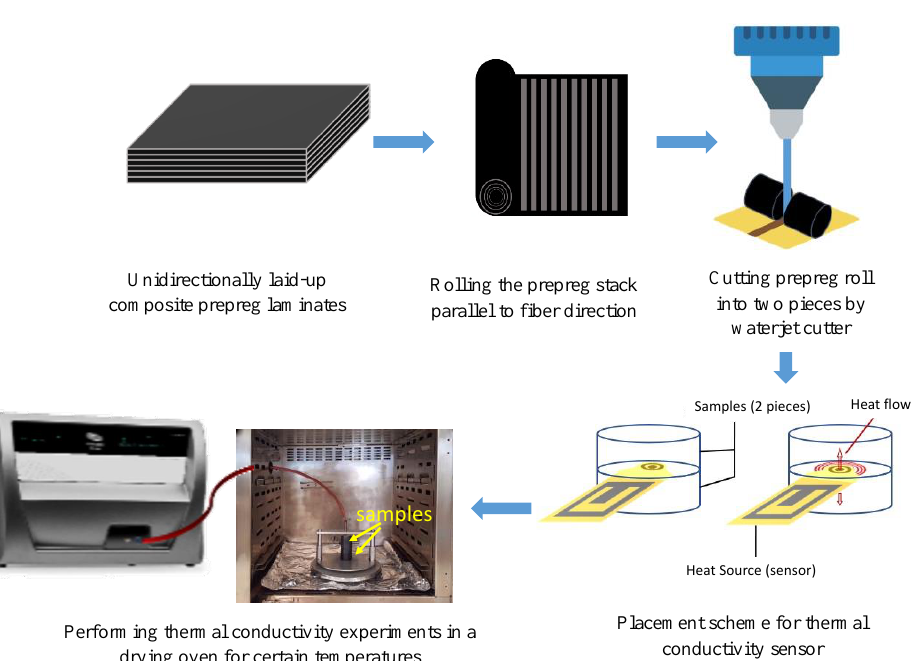
Figure 11. Experimental procedure of thermal conductivity characterization for the prepreg system.